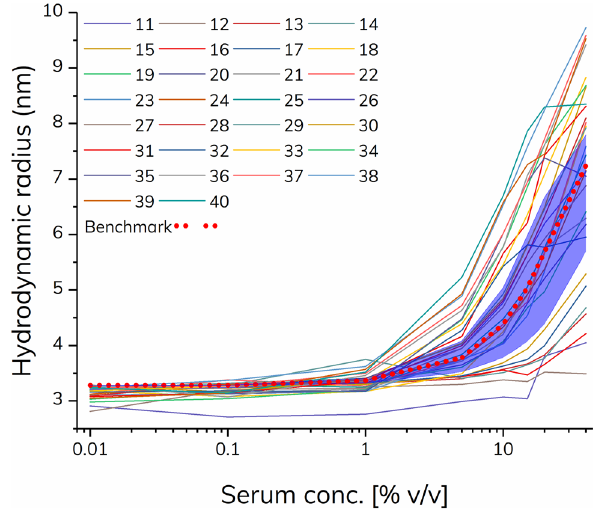
Figure 3. Experimental group (30 patients) depicted as lines with apparent hydrodynamic radius of TNF- α-AF488 (100 nM) as a function of serum concentration (0–40% v/v). The red dotted line shows theoretical benchmark values using the standard curve in 20% v/v plasma. The blue zone demonstrates 50% deviation in steady-state serum concentration of 8 µg/mL (~ 54 nM)